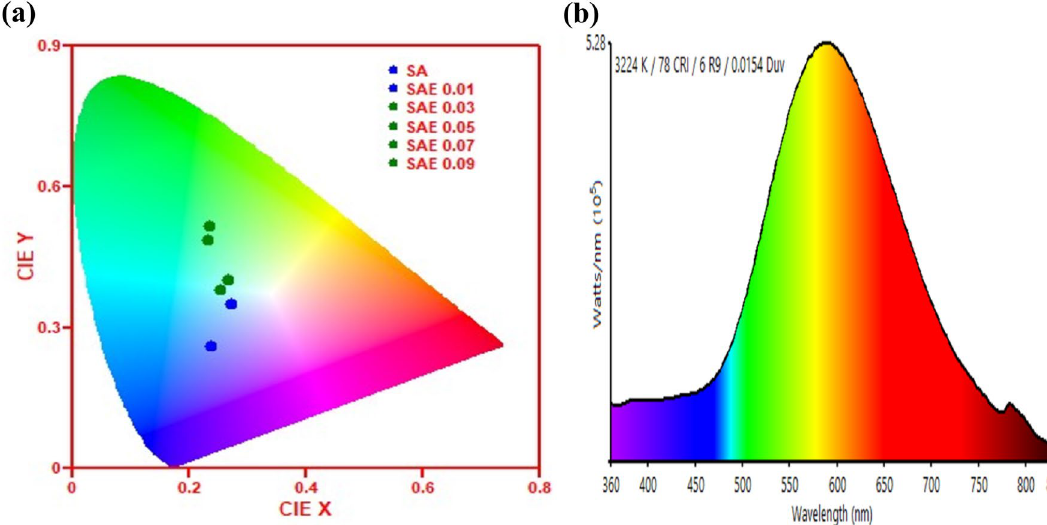
Figure 12. Photoluminescence CIE diagram of Sr 1−x Al 2 O 4 :Eu x (x = 0.00, 0.01, 0.03, 0.05, 0.07, and 0.09) phosphor (SAE phosphor) ( a ), Typical spectrum graph for Sr 1−x Al 2 O 4 :Eu x (x = 0.05) (SAE 0.05) phosphor ( b ).